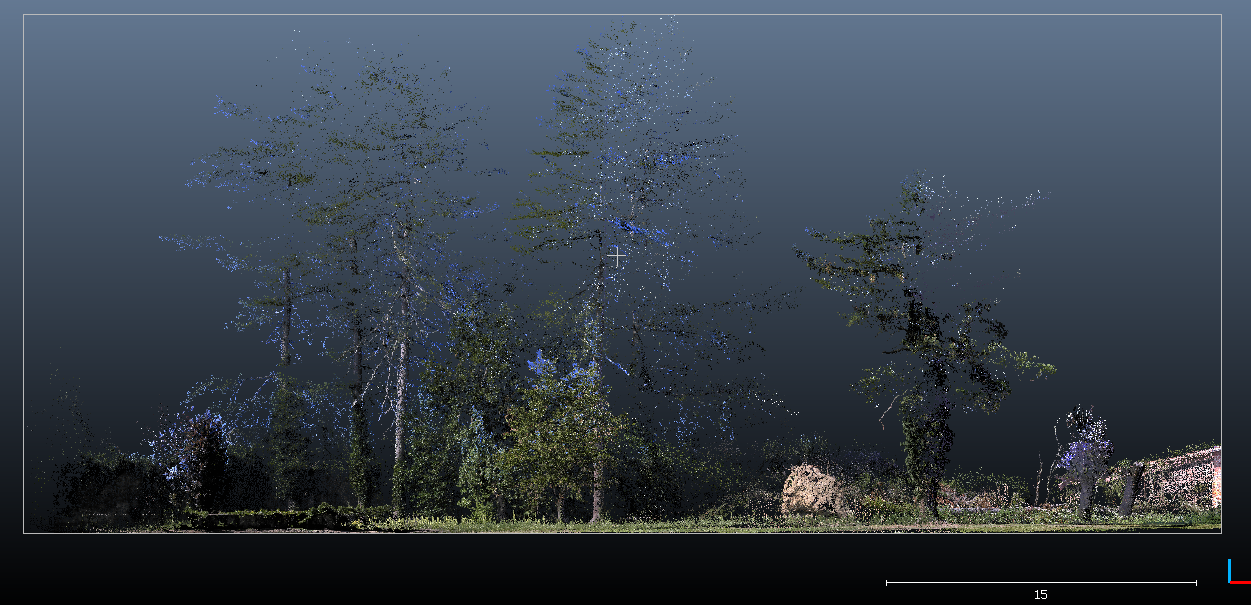
Figure 34. Vegetation of the castle captured by the Trimble SX10 scanning